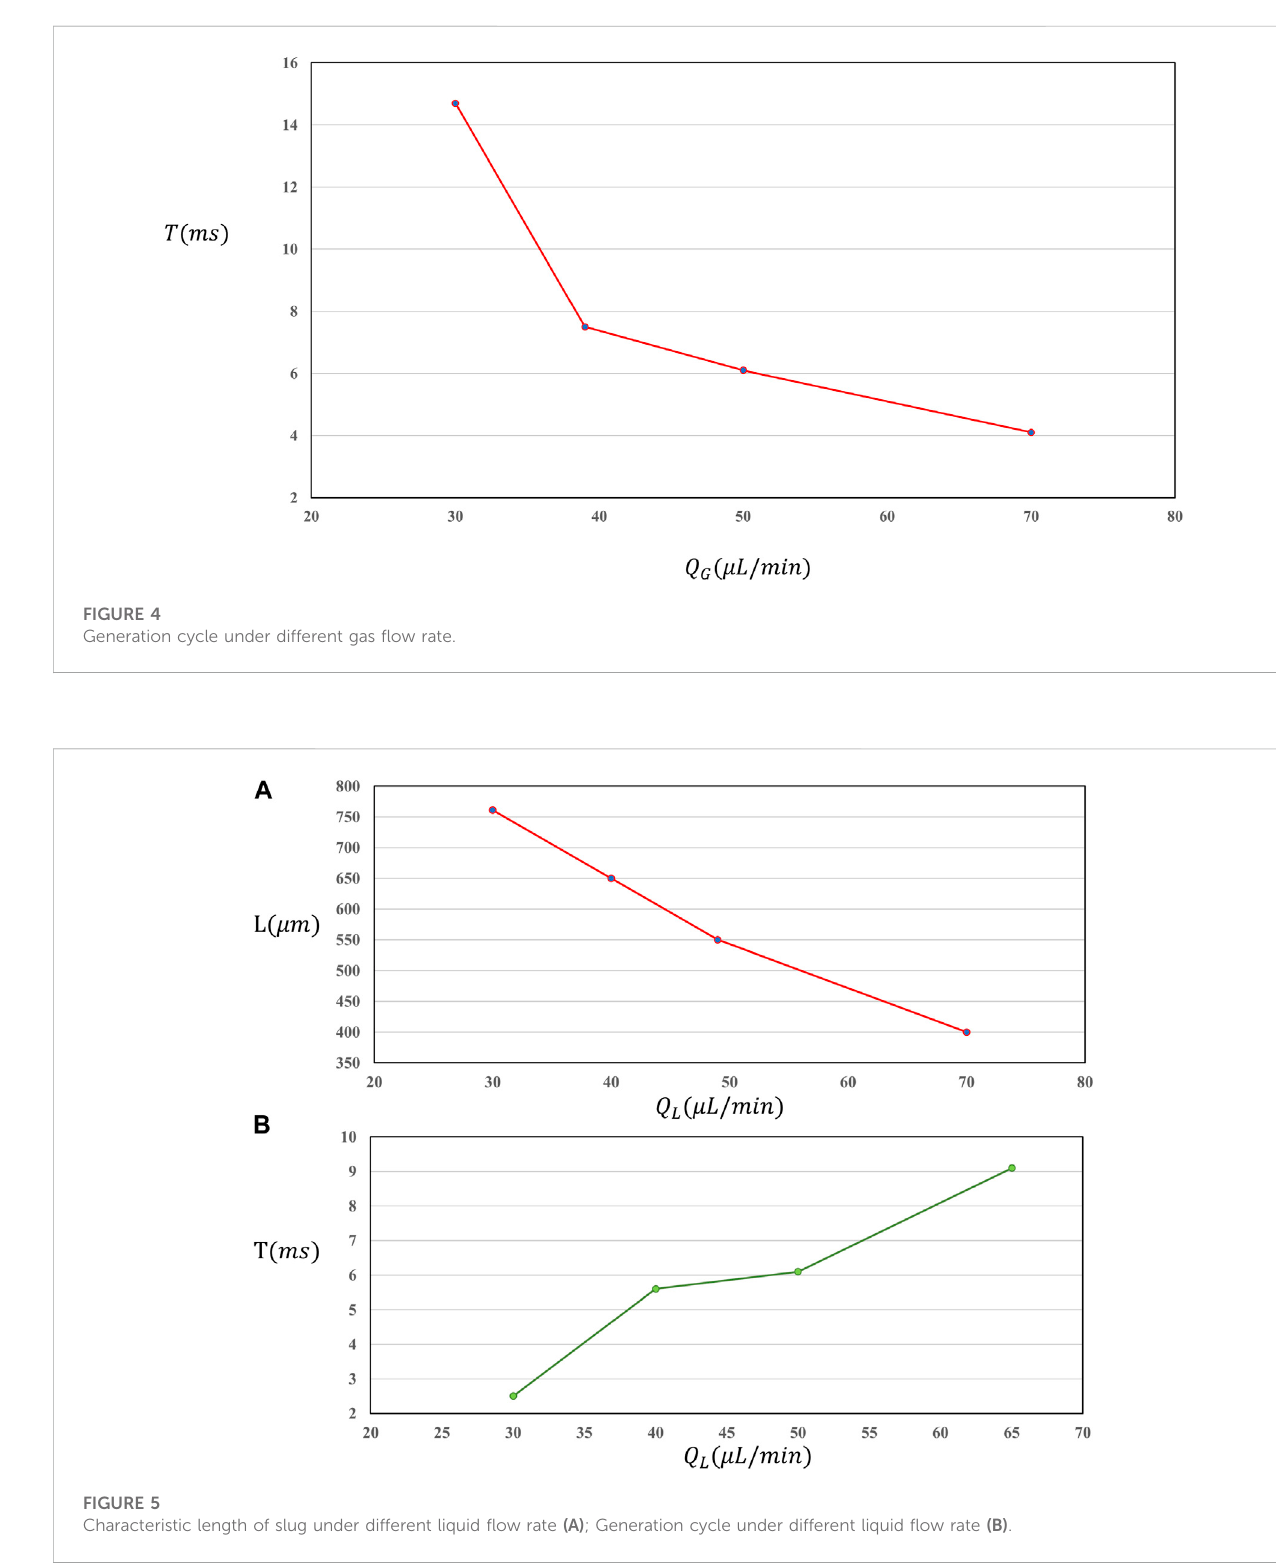
liquid phase before entering the T-shaped intersection during the generation of slug fl ow, and monitoring point C records the pressure changes near the gas phase fracture location. The monitoring line can record the change of two-phase length and pressure during the